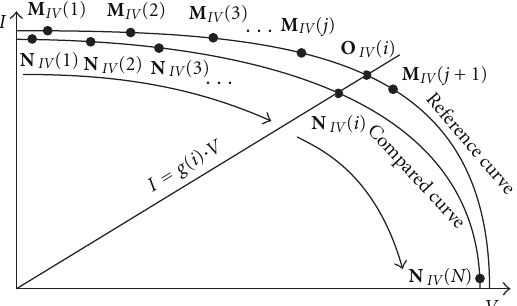
Figure 2: Error calculation geometry for a forward sweep.